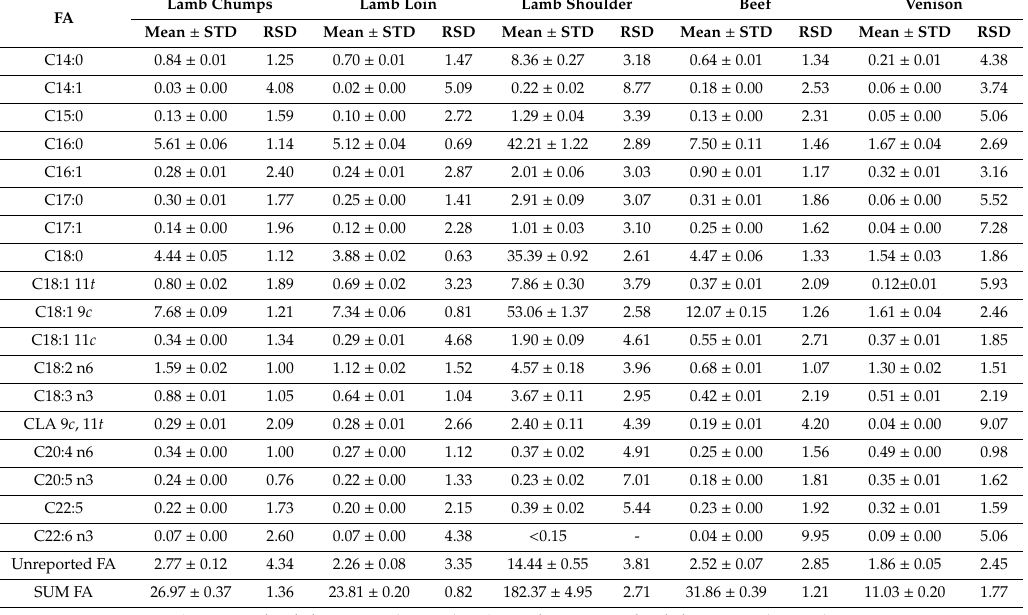
Table 3. FA composition (mg / g fresh meat) of meat cuts with di ff erent fat contents (boneless lamb chumps with 2.8% of intramuscular fat (IMF), boneless lamb loin with 2.4% IMF, boneless beef with 3.34% IMF, boneless venison with 1.15% IMF and boneless lamb shoulder with 18.84% IMF)), analysed using the optimised one-step direct transmethylation ( n =